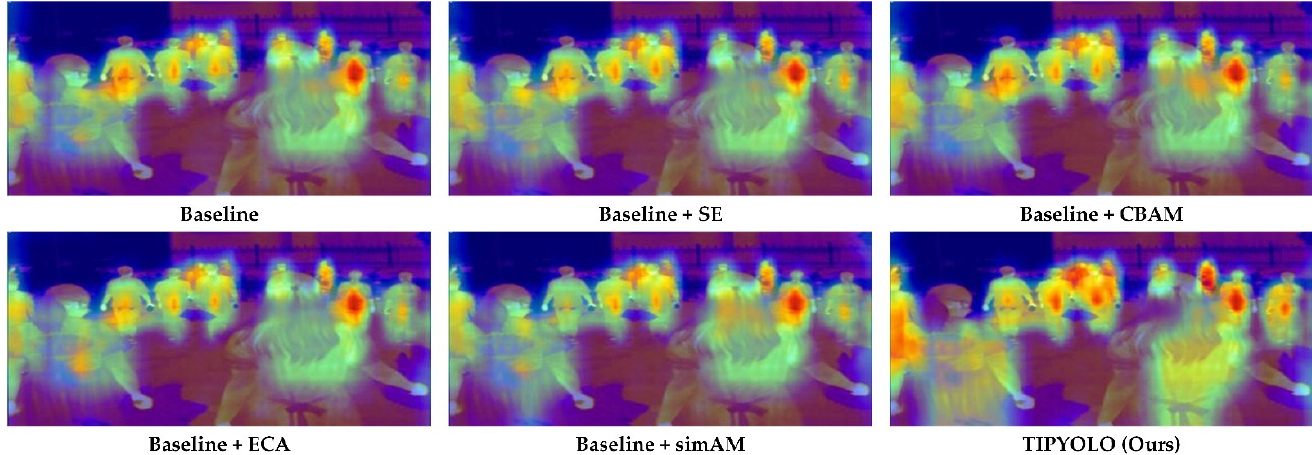
Figure 9. The activation heatmap for each detector generated using GradCAM.